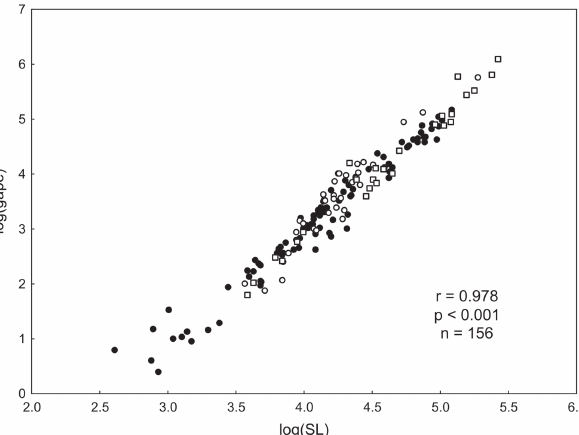
Fig. 9. Variation of gape size (log transformed) with standard length (SL, log transformed) for individuals of three species of Lutjanus . Filled circles: L. argentiventris ; Open circles: L. novemfasciatus ; Squares: L. colorado